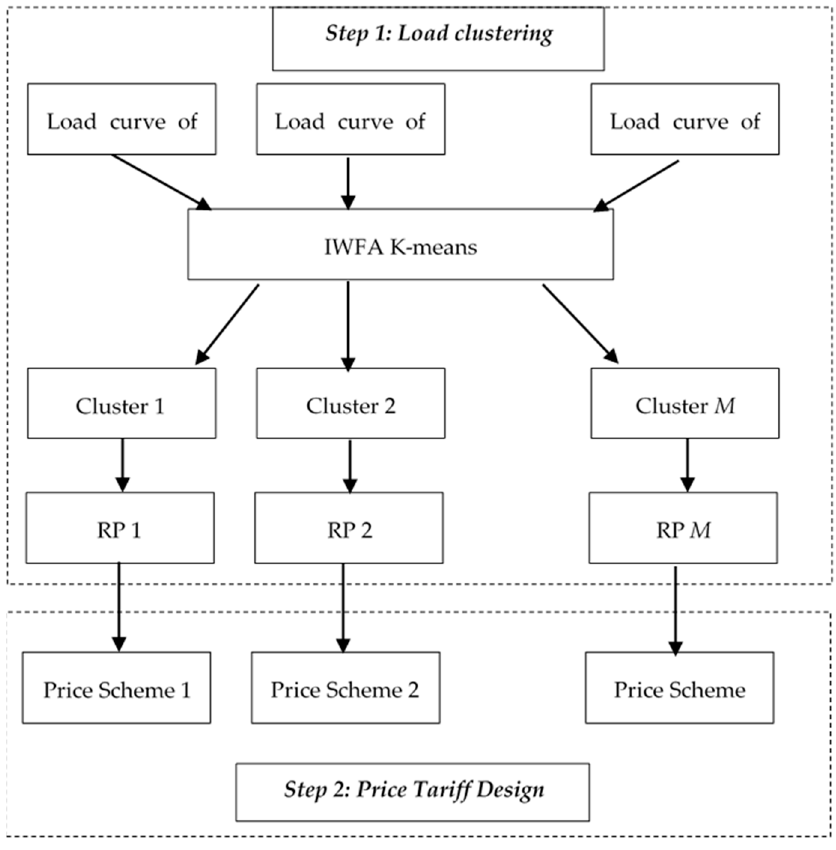
Figure 1. The proposed two-step pricing scheme.